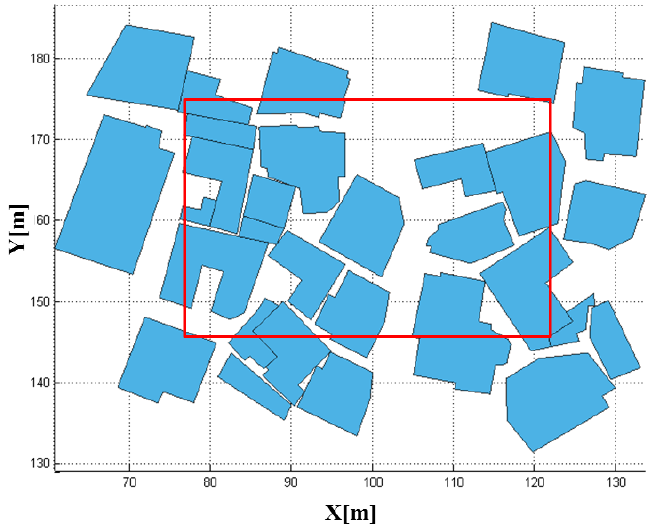
Figure 15. Target models (buildings) in the test area (within red boundary).